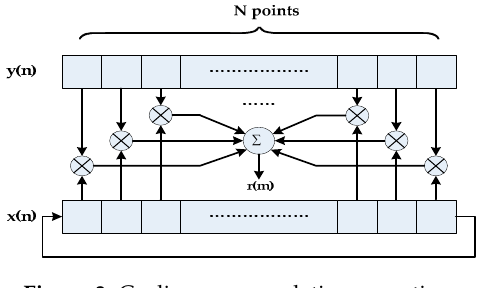
Figure 3. Cyclic cross-correlation operation.